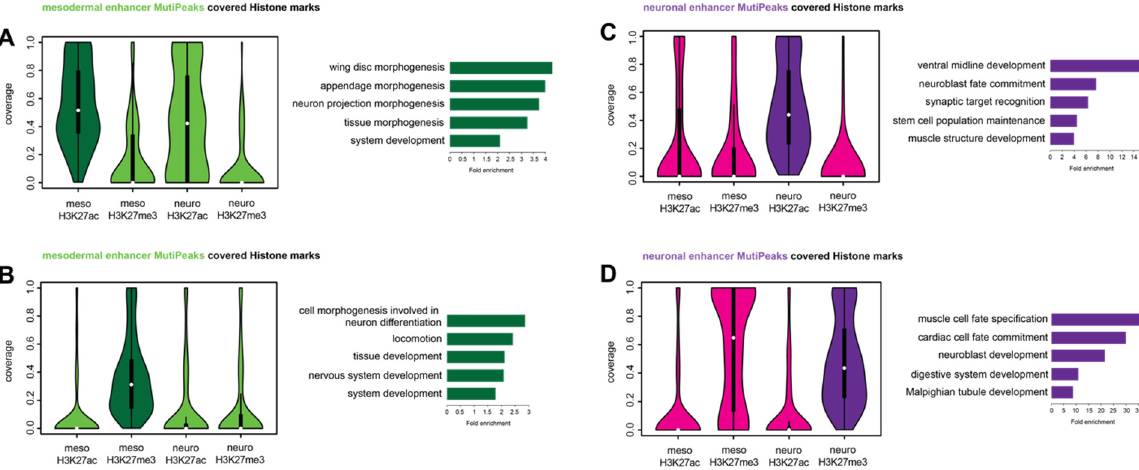
Figure 4. Histone modification at tissue-specific Ubx chromatin sites are different. ( A , B ) Ubx bound mesoderm-specific enhancers from the meso_ONLYpeaks data set were analyzed with respect to histone mark distribution. ( A ) The focus is on mesodermal, Ubx-bound regions covered with H3K27ac marks (dark green). These genomic regions are also covered with acetylation marks in the neuronal system (neuro H3K27ac, light green). Bar diagram: GO-term analysis of the selected data (dark green). ( B ) The focus is on mesodermal, Ubx bound regions covered with H3K27me3 marks (dark green), these regions do not contain any other histone mark studied. Bar diagram: GO-term analysis of the selected data (dark green). ( C,D ) Ubx bound neuronal-specific enhancers from the neuro_ONLYpeaks data set were analyzed with respect to their histone mark distribution. ( C ) The focus is on neuronal, Ubx-bound regions covered with H3K27ac marks (dark